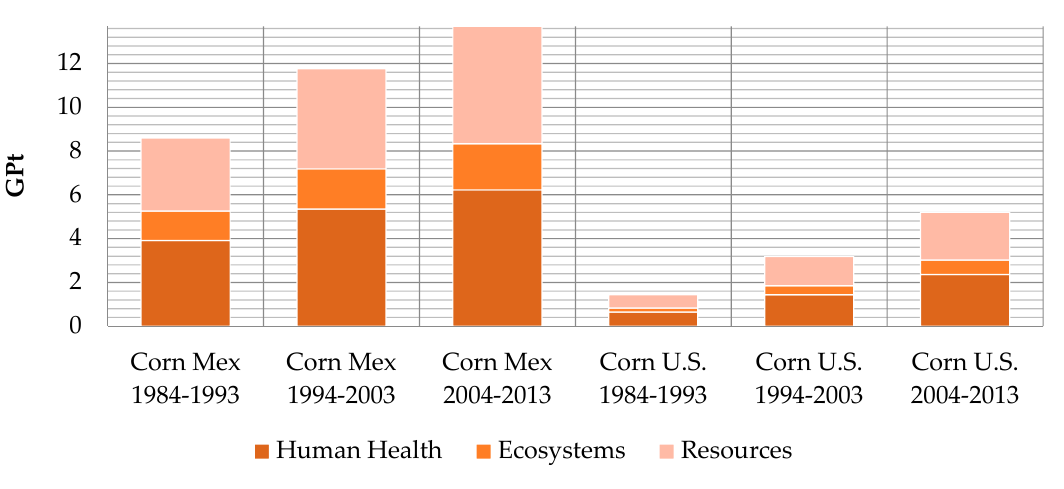
Figure 1. Comparison of product station by the ReCiPe Endpoint (H) V1.10/World ReCiPe H/H/single-score method.